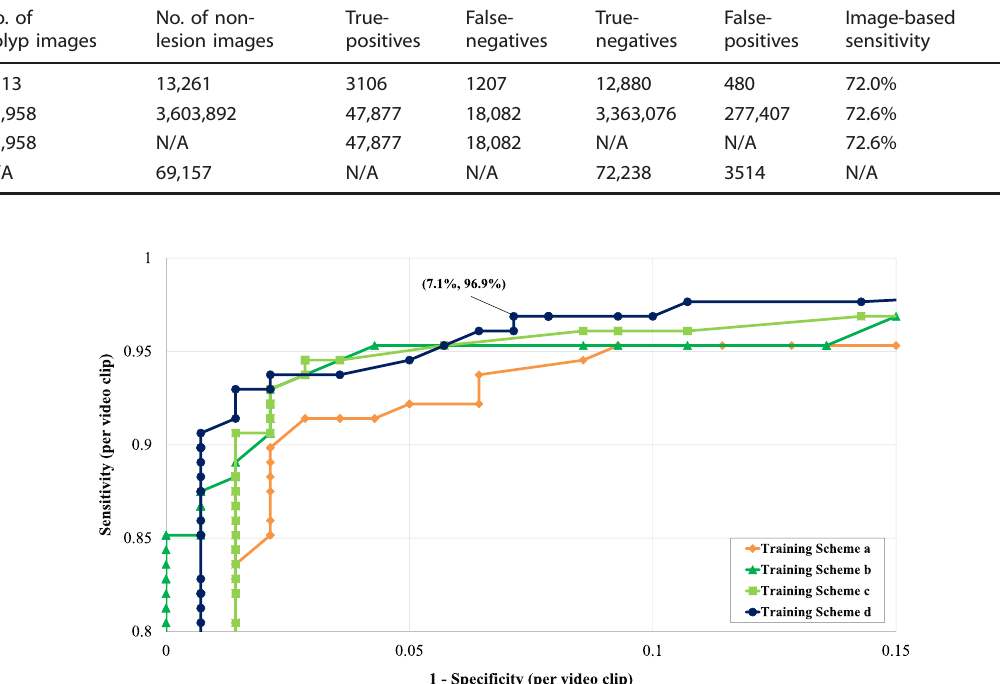
Fig. 3 The polyp-based performance of AI-doscopist on Datasets B.1 and B.2 under different training schemes. Although Training Schemes b, c, and d resulted in signi fi cant different performances in the image-based analysis (as shown in Fig. 2), their performances are comparable in the polyp-based analysis.